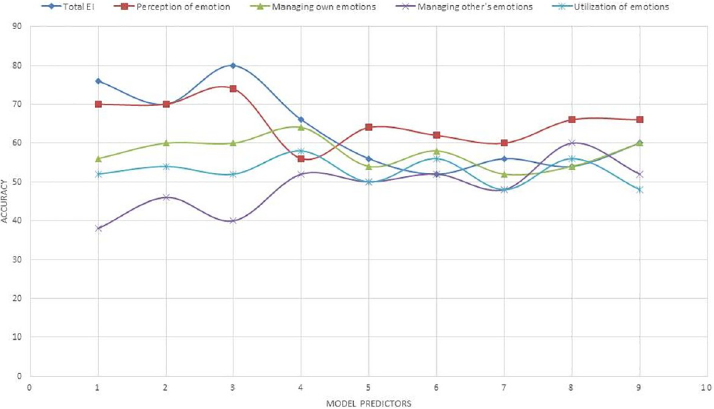
Fig 8. Model accuracy with linear SVM for different sets of predictors. 1: Cardiac response; 2: Cardiac reactivity; 3: Cardiac response and reactivity; 4: Respiratory response; 5: Respiratory reactivity; 6: Respiratory response and reactivity; 7: Autonomic (cardiac + breath) response; 8: Autonomic reactivity; 9: Autonomic response and